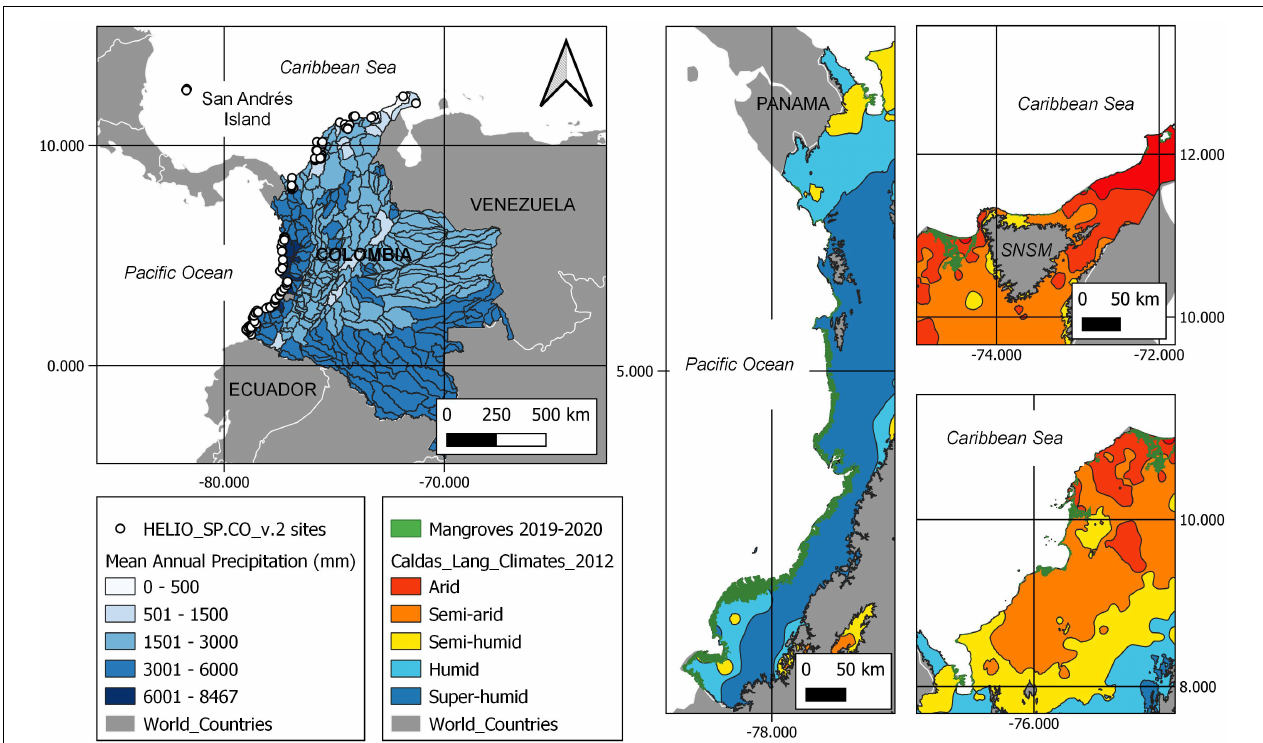
FIGURE 1 | Sites included in HELIO_SP.CO v.2 database are shown relative to mean annual precipitation within watersheds (left: note the location of San Andrés Island, oceanic territory in the Caribbean Sea-OC). Climates according to Caldas-Lang classification are shown for the entire Pacific coast and northern and southern stretches of the continental Caribbean coast (center and right). Sierra Nevada de Santa Marta (SNSM: a major coastal massif in the northern Caribbean coastal plain), Western Cordillera (one of the branches of the Northern Andes), and Serranía del Baudó (a satellite system running parallel to the northern Pacific coast) were excluded from the representation of climates in the insets (shown in gray color). Climate data from IDEAM, and mangrove map (2019–2020) from Valencia-Palacios and Blanco-Libreros (2021). Drawn with QGIS